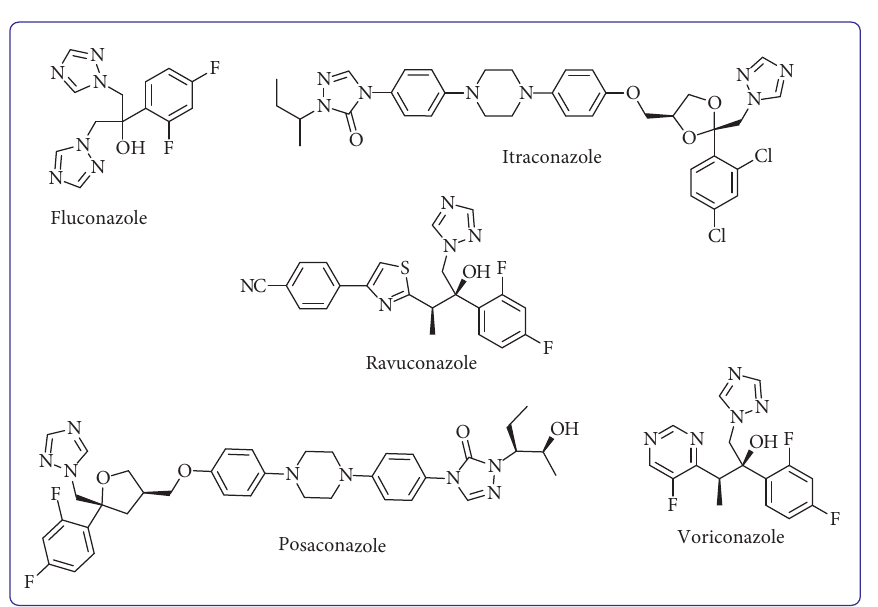
Figure 2: A few examples of antifungal